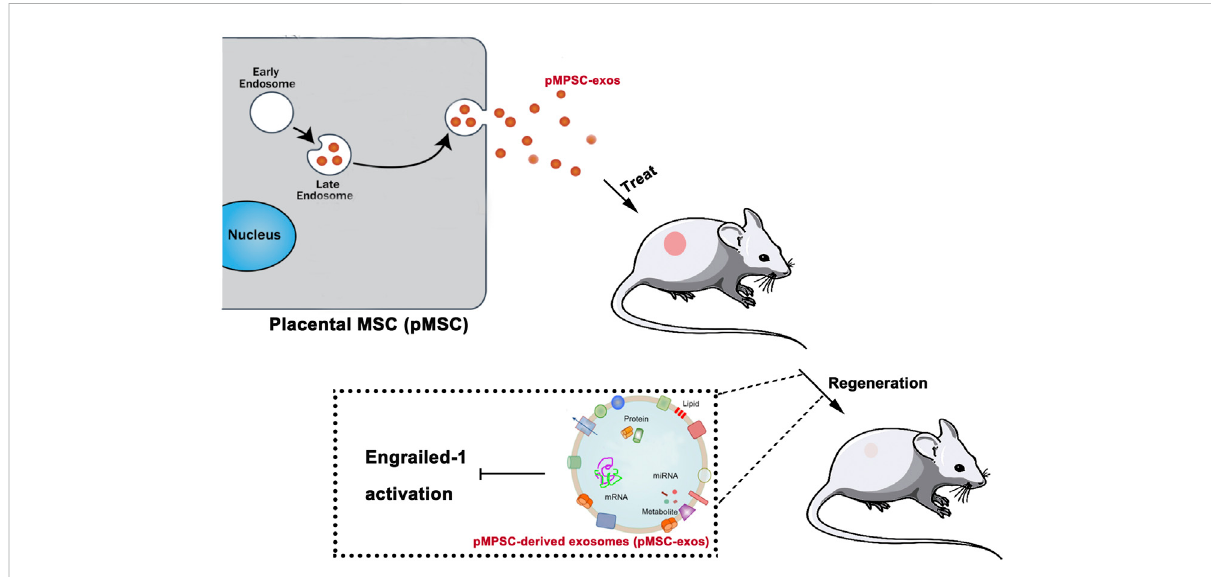
FIGURE 8 pMSC-exosinducedwoundregenerationviainhibitingEngrailed-1activation. “ Cargos ” ofpMSC-exosincludingDNAs,miRNAs,proteinfactors, etc. inhibit Engrailed-1